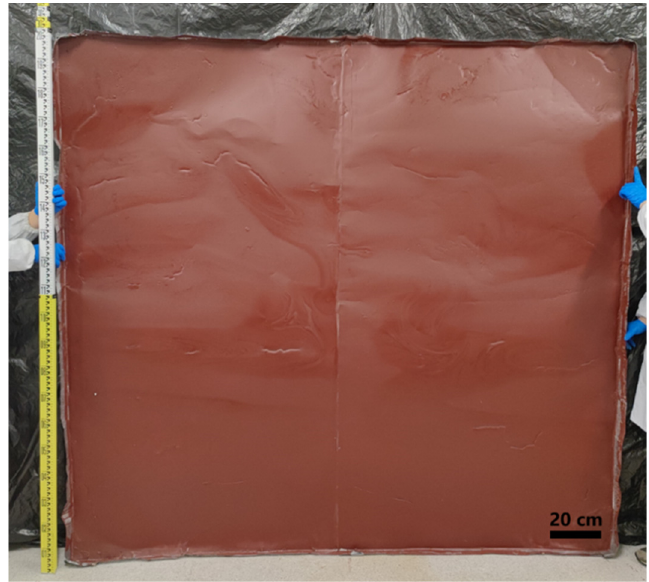
× 2.2 m flame-retardant